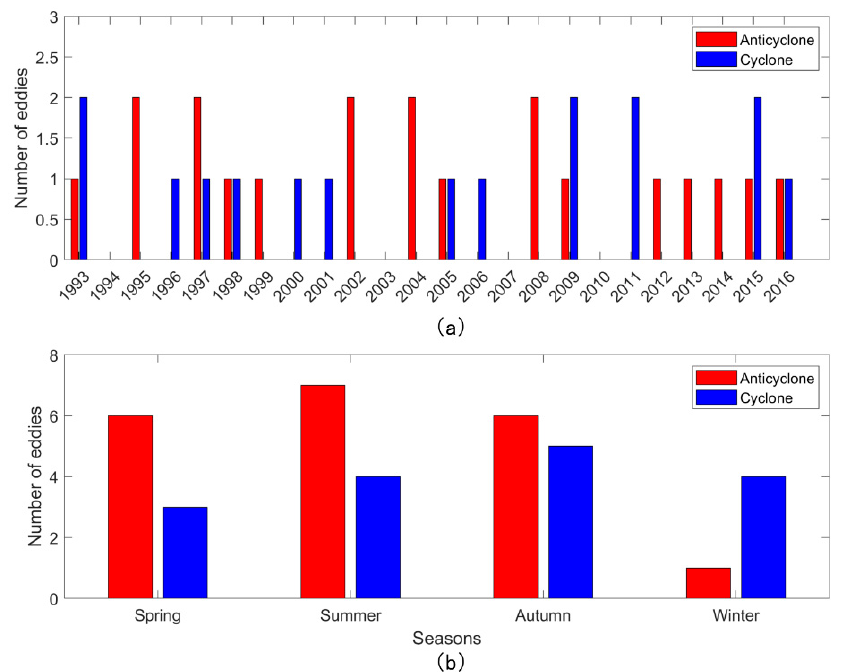
Figure 11. ( a ) Interannual and ( b ) seasonal statistics of the shelf ‐ internal ‐ generation type. The red columns indicate the anticyclonic eddies. The blue columns indicate the cyclonic eddies.